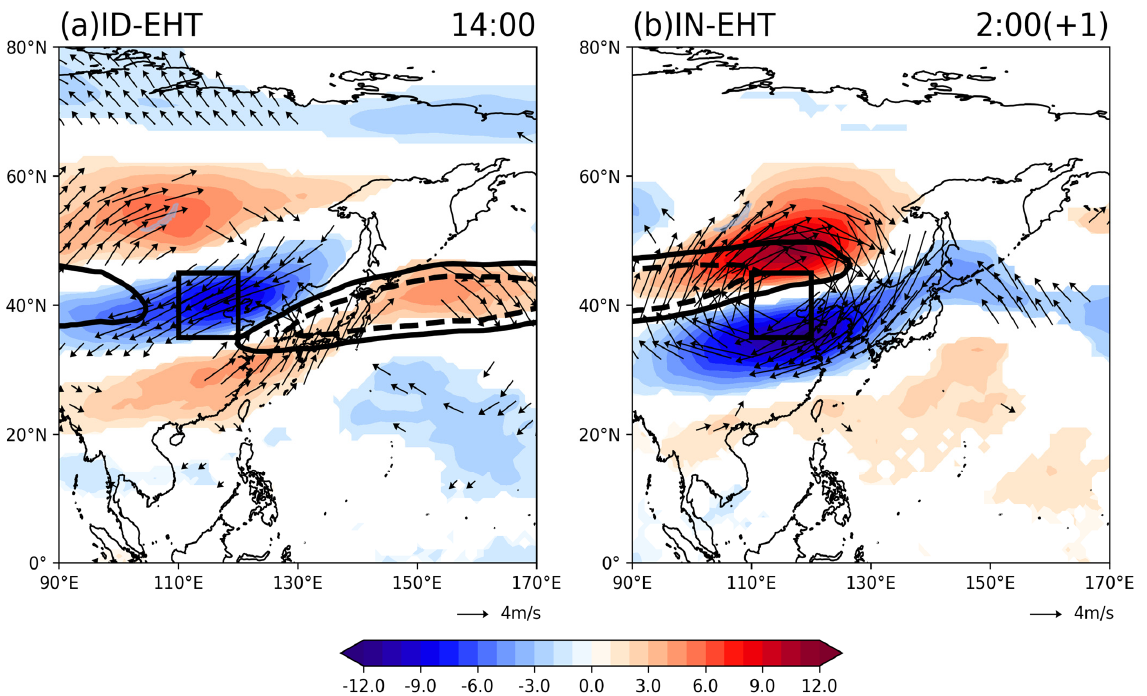
Figure 8. Composite anomalies of 200 hPa wind (arrows; units: m/s) and zonal wind (shading, units: m/s) at 14:00 ( a ) on the day for ID-EHT and at 2:00 ( b ) on the next day for IN-EHT. The black solid and dotted contours represent the westerly jet stream domain (depicted by zonal wind speed of 25 m/s and 30 m/s); Only wind anomalies that are significant at the 95% confidence level are retained.